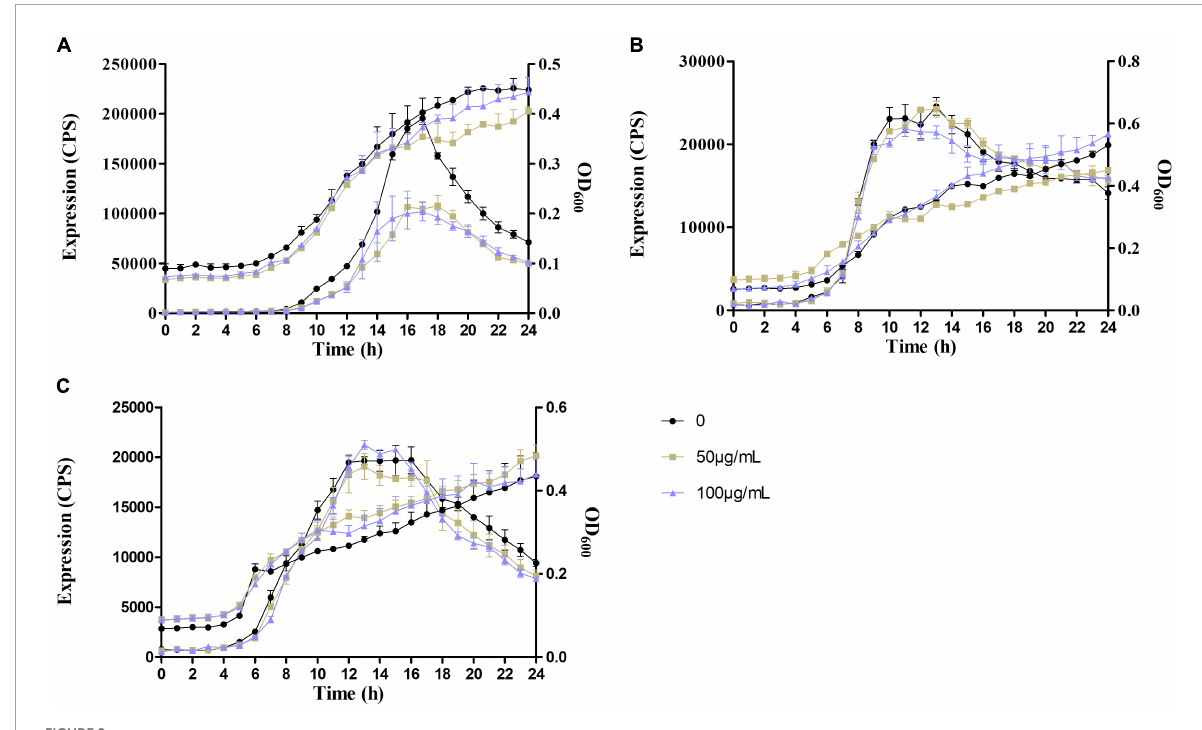
FIGURE9 Effects of SA on the expression of lasB and pqsA in the QS quintuple mutants. (A) The expression of lasB in QM-1(pKD- lasB ); (B) the expression of lasB in QM-2(pKD- lasB ); and (C) the expression of pqsA in QM-3(pKD- pqsA ). All data were expressed as mean ± SD values with three independent experiments performed in